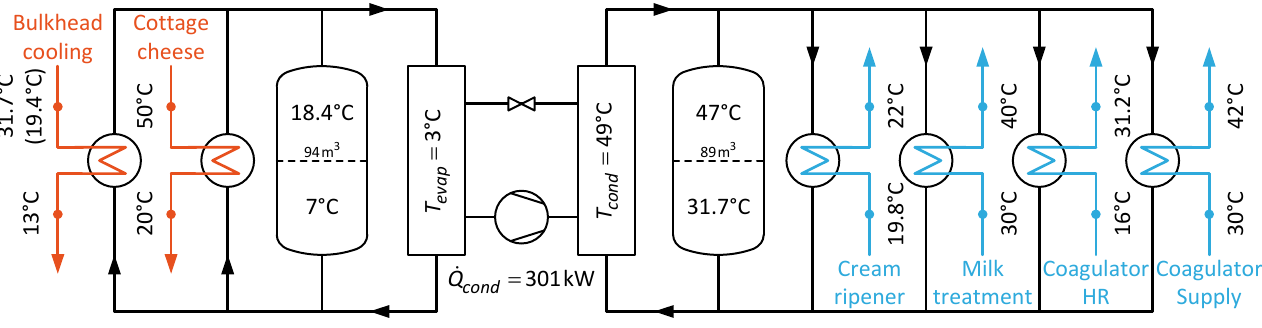
Figure 14. Schematic of solution Variant 3: HP system with no IHR at all (all HR through the